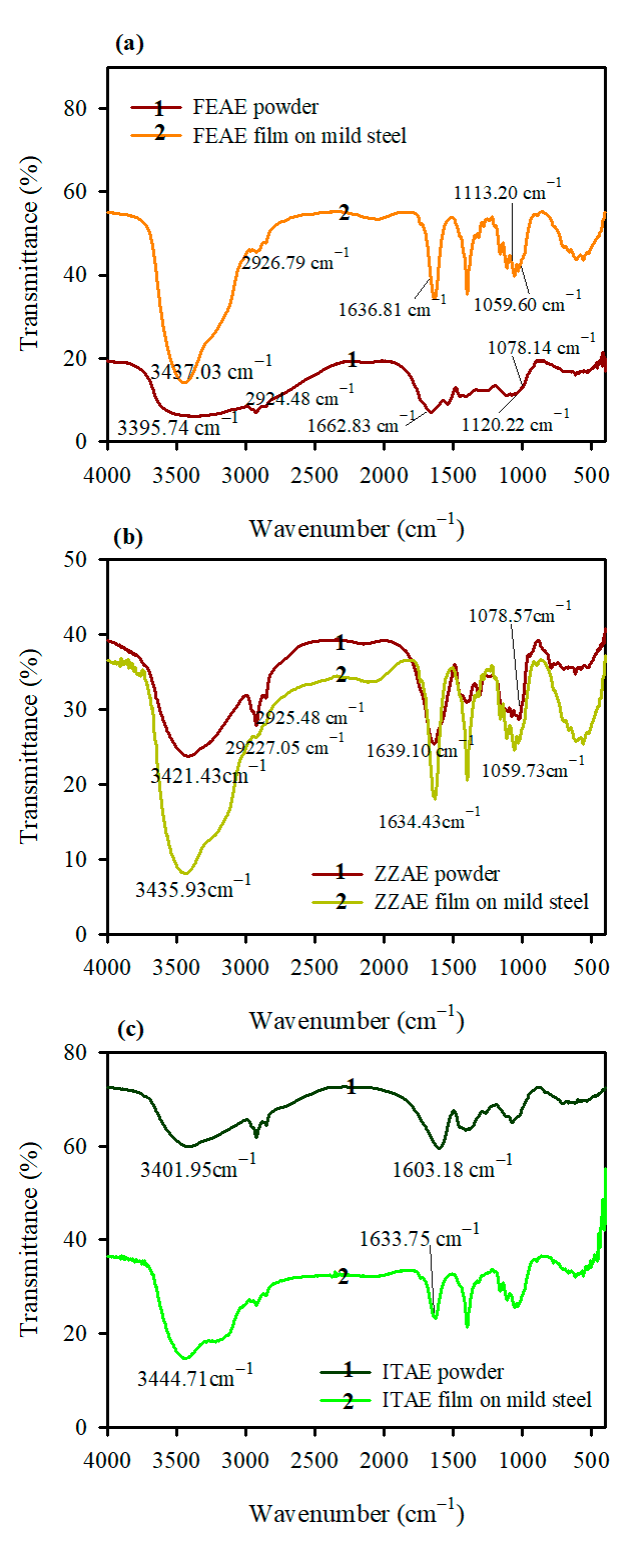
Figure 4. FT-IR spectra of ( a ) FEAE, ( b ) ZZAE, and ( c ) ITAE powder and film formed on the mild steel surface after immersion in 2 M H 3 PO 4 containing 2.5 g L − 1 of the studied plant extracts.